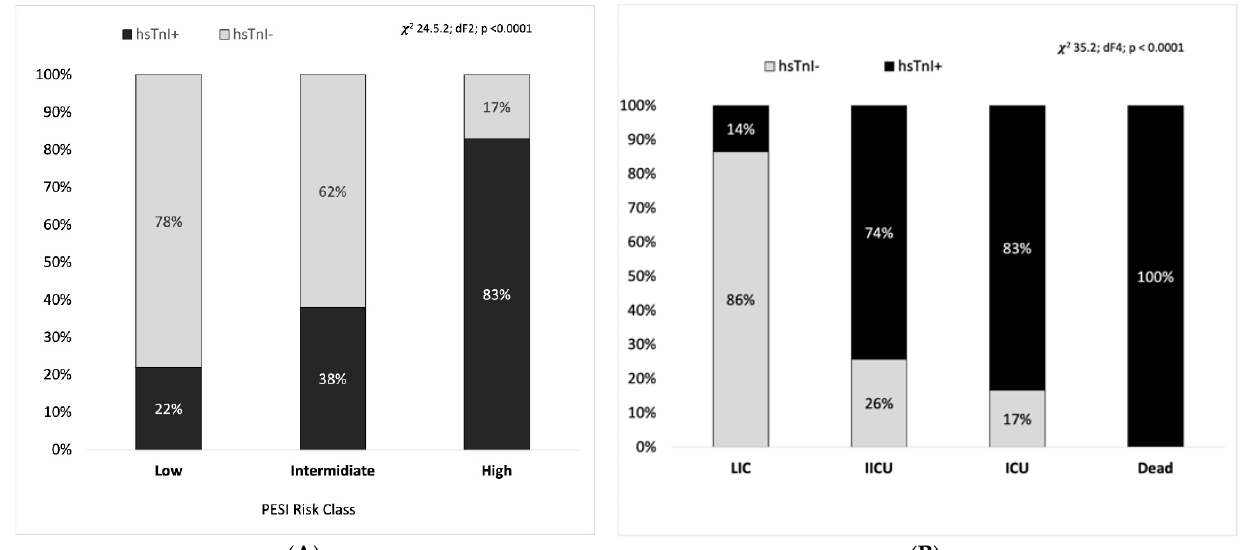
Figure 2. ( A ): Comparison of the hs-cTnI+ group with the hs-cTnI- group in the PESI low, intermediate and high risk class respectively, in PS analysis. ( B ): Comparison of the hs-cTnI+ group with the hs-cTnI- group in the different department of admission, grouped for the intensity of care (LIC: low intensive care; IICU: intermediate care unit; ICU: intensive care unit), in PS analysis; comparison of the hs-cTnI+ group with the hs-cTnI- group in patient died in ED, in PS analysis.